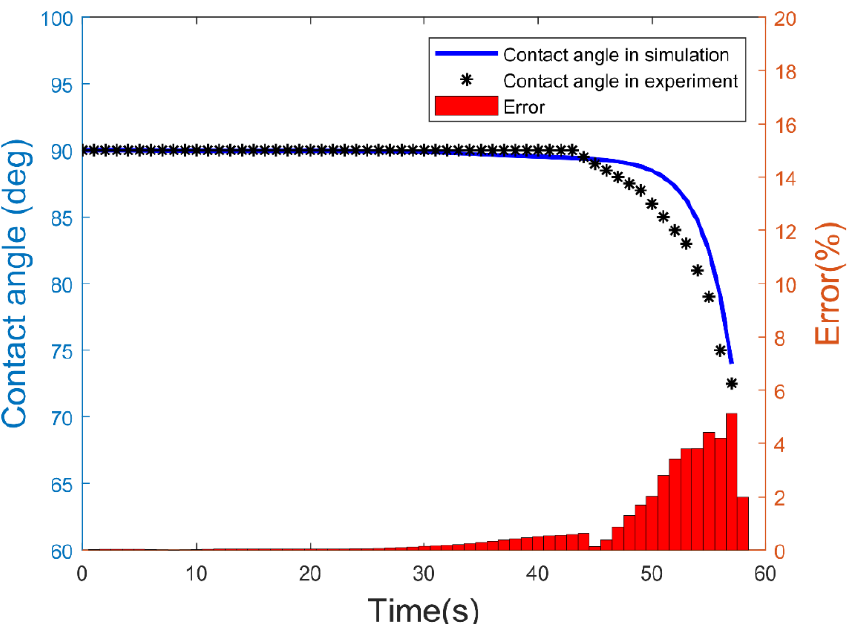
Figure 6. Change of the contact angle during electrowetting in the experiment versus the simulation, shown in Figure 4.